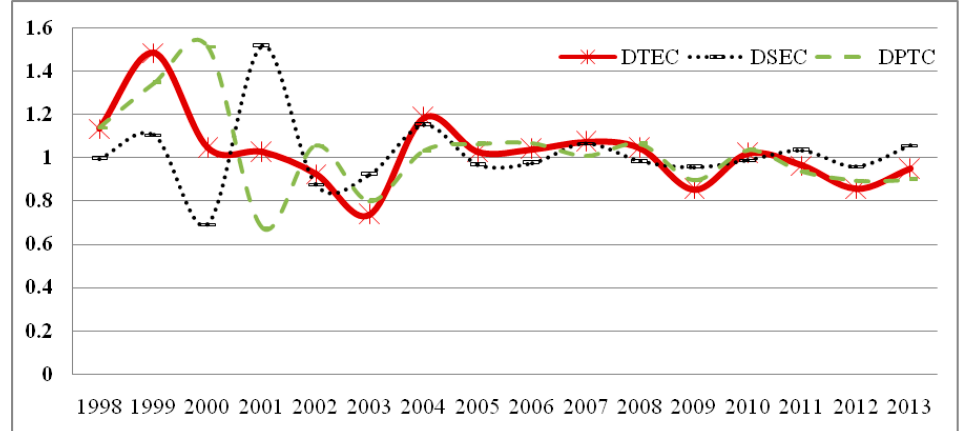
Figure 3. Decomposing dynamic technology efficiency changes in China.